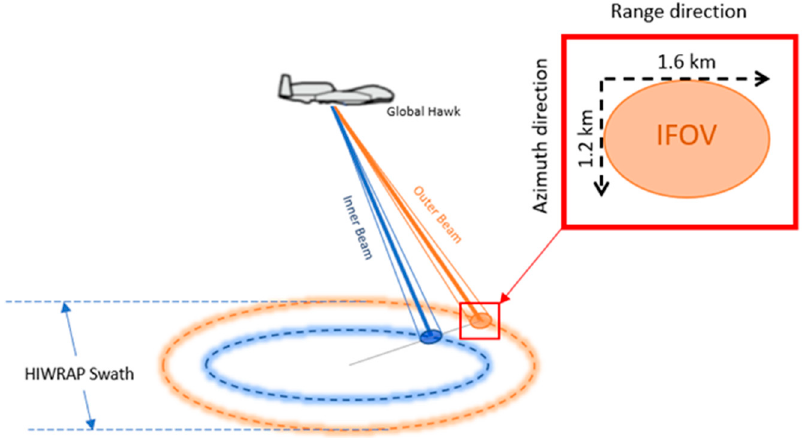
Figure 2. HIWRAP dual-beam, conical scan patterns on the surface of the earth, and the insert shows the antenna surface footprint (IFOV) dimensions.